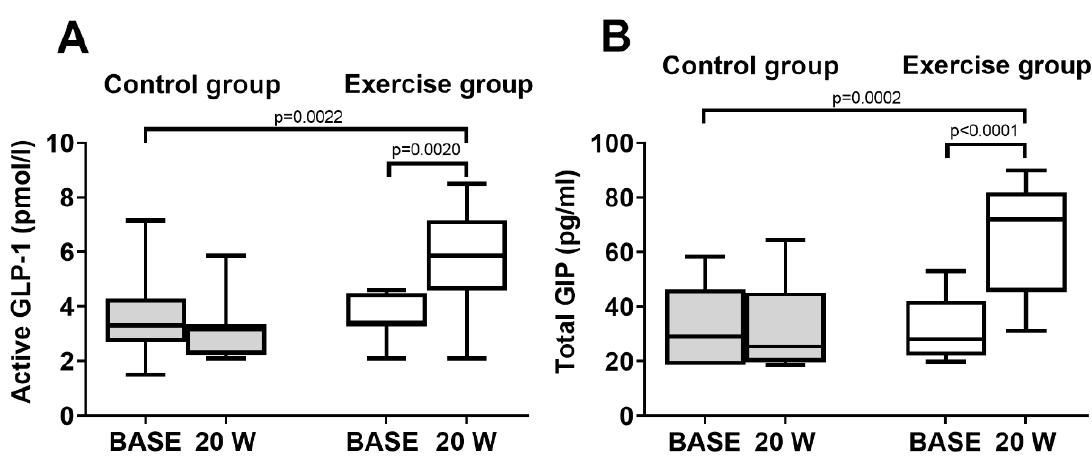
Figure 2. Endogenous incretin levels measured baseline (BASE) and after 20 weeks (W20) in the control group and exercise group. ( A ) Box and whisker plot of GLP-1. ( B ) Box and whisker plot of GIP.